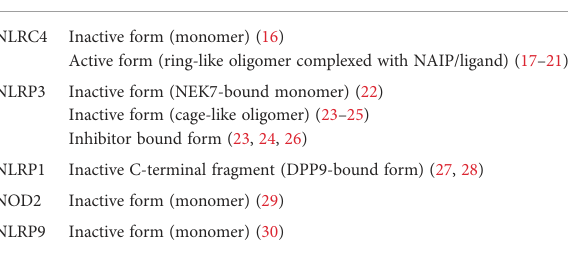
TABLE 1 Summary of structural studies of